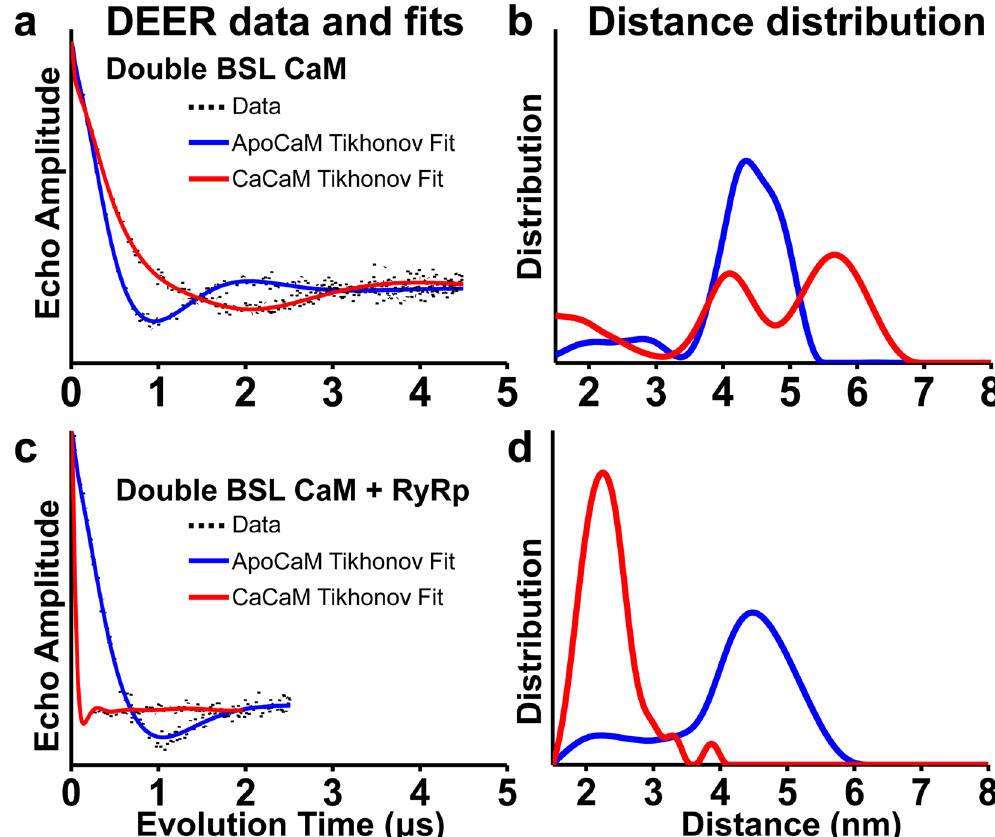
Figure 3. Intramolecular (lobe-to-lobe within CaM) DEER distance measurements resolving the Ca- dependent structural states (compact, closed and open) of double-labeled BSL-CaM, in the absence of Ca (blue, apo) or presence of saturating Ca (red). CaM was labeled at positions T34CS38C in the N-lobe and R106CT110C in the C-lobe. ( a,b ) DEER waveforms (black), best fits and distance distributions from Tikhonov regularization (blue/red) for double BSL-CaM (Fig. 1a,b). ( c,d ) DEER waveforms (black), best fits and distance distributions from Tikhonov regularization (blue/red) for the complex of double BSL-CaM and RyRp (Fig.